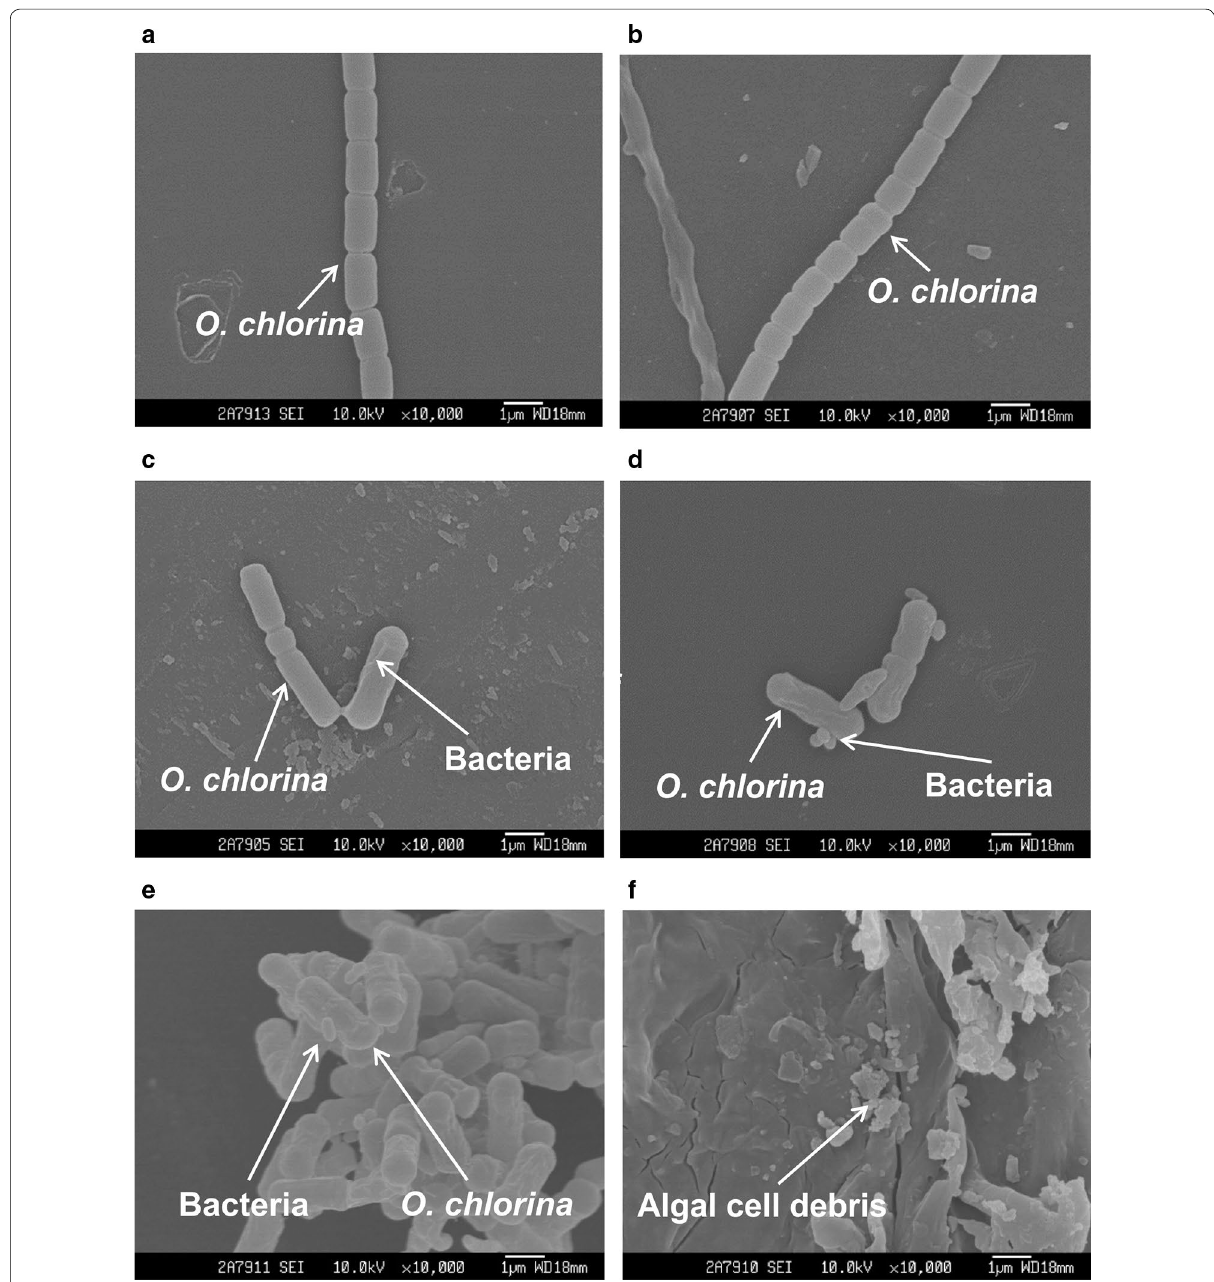
Fig. 3 Scanning electron micrographs of the effects of CZBC1 on Oscillatoria chlorina cells. a initial stage in Oc‑C and Oc‑F; b initial stage in Oc‑B; c early stage of alginolysis in Oc‑B; d , e middle stage of alginolysis in Oc‑B; f late stage of alginolysis in Oc‑B. Oc‑C: O. chlorina control group; Oc‑B: O. chlorina bacterial suspension group; Oc‑F: O. chlorina sterile filtrate + +